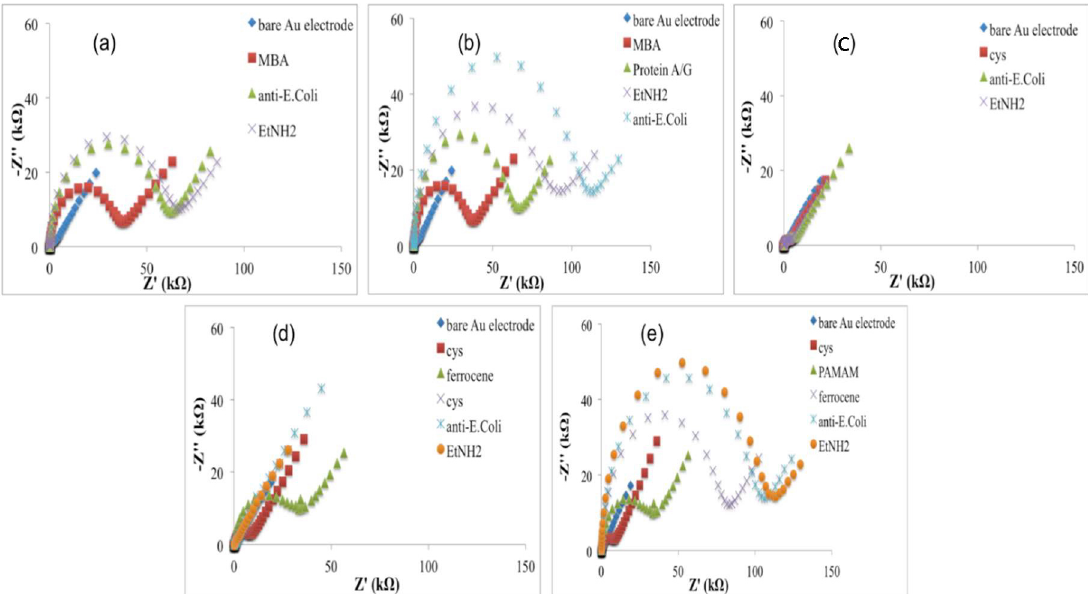
Figure 3. EIS responses to all immunosensor fabrication steps for all immobilization procedures tested in this work: ( a ) Au-MBA-Ab; ( b ) Au-MBA-ProteinA/G-Ab; ( c ) Au-Cys-Ab; ( d ) Au-Cys-Ferrocene-Ab; ( e ) Cys-PAMAM-Ferrocene-Ab.